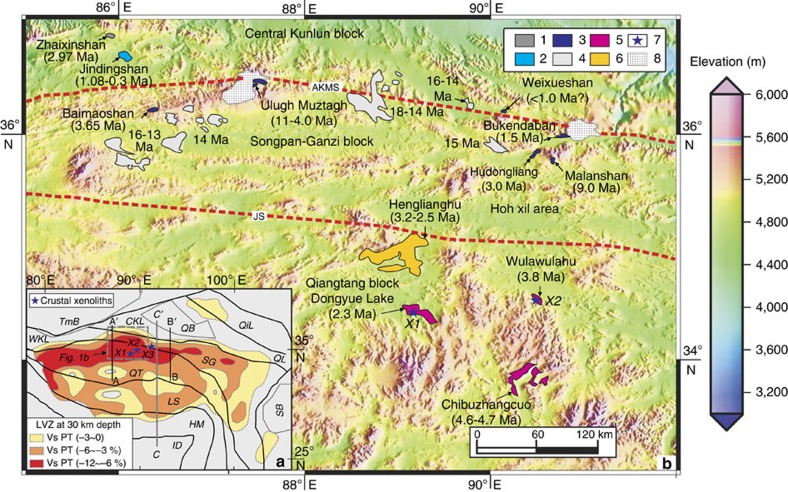
A topographic map of Tibet showing the tectonic blocks and the Late Cenozoic lavas and variations in crustal velocity.(a) The amplitude of the crustal low velocity zone (LVZ) Vs perturbation (PT) at 30-km depth beneath Tibet. This figure is modified from Yang et al.22 and Hacker et al.17. Lines A–A′ and B–B′ are similar to Seismic sections A–A′ and B–B′ of Figs 9 and 11 of Yang et al.22, and they delineate the locations of the vertical cross-sections shown in Fig. 4c. Line C–C′ is the line of the schematic section for Fig. 2. The tectonic units labelled are: CKL, Central Kunlun; HM, Himalaya; ID, India; LS, Lhasa; QB, Qaidam basin; QiL, Qilian; QL, Qinling; QT, Qiangtang; SB, Sichuan basin; SG, Songpan-Ganzi; TmB, Tarim basin; WKL, western Kunlun. X1, X2 and X3: crustal xenoliths locations. (b) A sketch map showing the locations of Late Cenozoic lavas and associated crustal xenoliths in central and northern Tibet. The original digital topography data for the central and northern Tibetan Plateau are from the Earth Resources Observation and Science (EROS) Center of United States Geological Survey (http://eros.usgs.gov/products/elevation/gtopo30.html). Main suture zones: AKMS, Anyimaqen-Kunlun-Muztagh; JS, Jinshajiang. Legends captions: (1) Pliocene (2.97 Myr ago) adakitic trachyandesites in the Zhaixinshan area (Supplementary Data set 1); (2) Quaternary (1.08–0.3 Myr ago) trachyandesites in the Jindingshan area (Supplementary Data set 1); (3) Miocene-Quaternary (11–1.5 Myr ago) rhyolites343536 (Supplementary Data set 1); (4) Miocene (18–13 Myr ago) potassic–ultrapotassic lavas531; (5) Pliocene-Quaternary (4.7–2.3 Myr ago) non-adakitic felsic volcanic lavas in the central-northern Qiangtang Block (Supplementary Data set 1); (6) Pliocene (3.2–2.5 Myr ago) adakitic rhyolites in the Henglianghu area of the central-northern Qiangtang Block (Supplementary Data set 1); (7) crustal xenoliths; (8) glaciers. The data for crustal xenoliths (Locations X1, X2 and X3) from Cenozoic magmatic rocks are as follows: X1, granulite xenoliths from the Dongyue Lake area of the Qiangtang Block23; X2, Granulite xenoliths from the Wulanwulahu area of the Qiangtang Block (Supplementary Table 1); X3, Garnet-bearing mafic granulite and amphibolite xenoliths from 28 Myr ago intrusive rocks in the Hoh Xil area of Songpan-Ganzi (Supplementary Table 1).